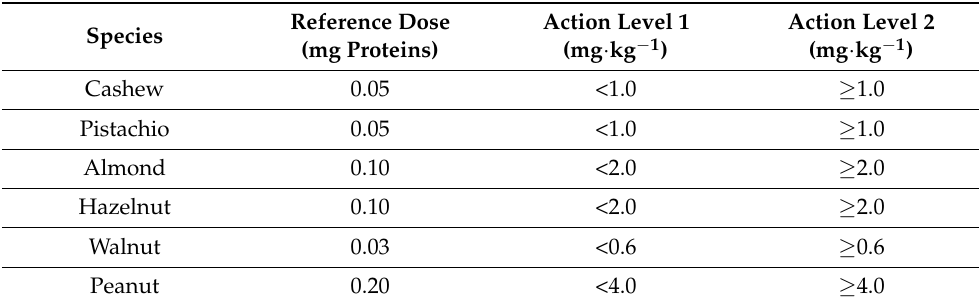
Table 5. VITAL ® 3.0 reference doses (also reported in the document “VITAL 3.0 (cid:48) : New and up- dated proposals for reference doses of food allergens”, freely accessible on the Internet with DOI: 10.17590/20200602-143608) and action levels for the five nuts under study and for peanuts. Data are referred to ED01 and 50 g reference amount. Data source: https://vital.allergenbureau.net/ dashboard/home/ (accessed on 5 December